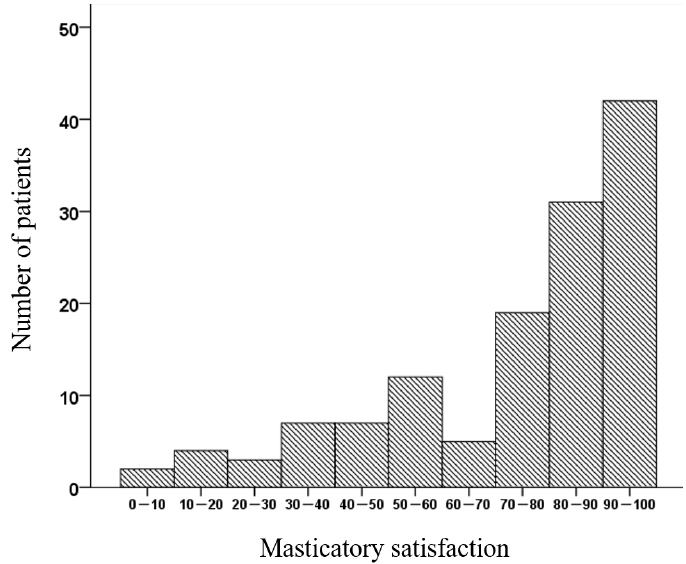
Figure 1. Distribution of masticatory satisfaction. Masticatory satisfaction—The response on a visual analog scale to the question “How do you feel about chewing comfort with your removable dentures?” The visual analog scale ranges from 0 (dissatisfaction with mastication) to 100 (satisfaction with mastication). Table 4. Relationship between masticatory satisfaction and survey